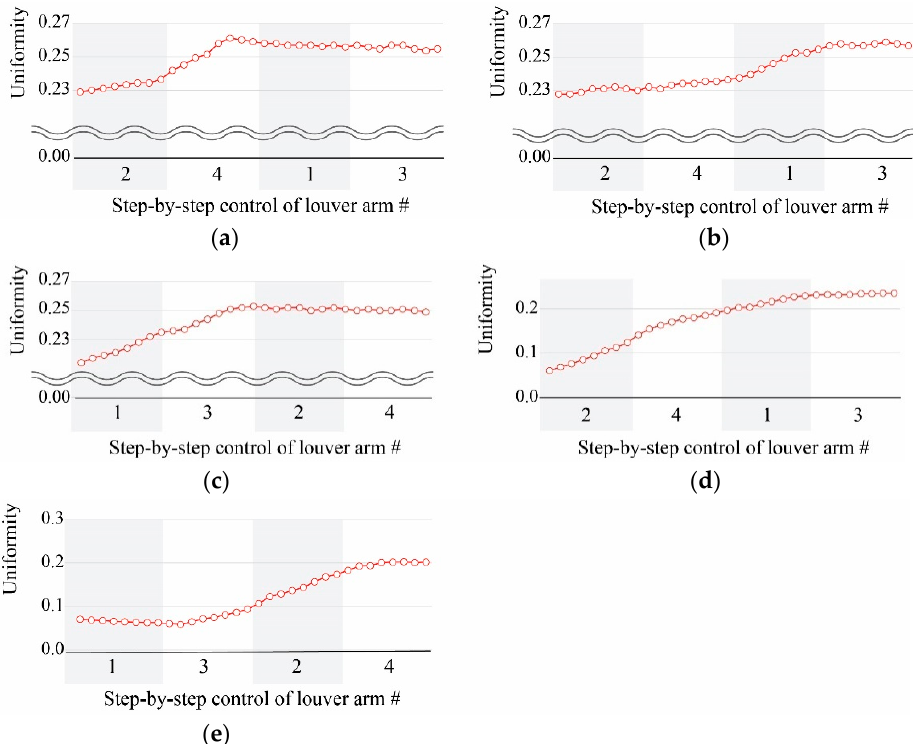
Figure 10. Uniformity by time during the summer according to operating Case 5. ( a ) From 10:00 to